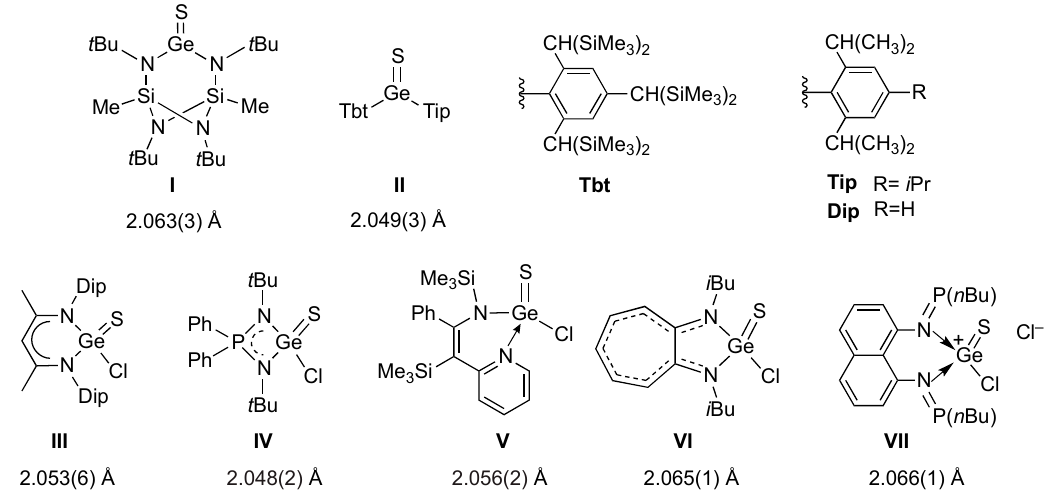
Figure 1. Ge=S-containing compounds and Ge=S bond length.